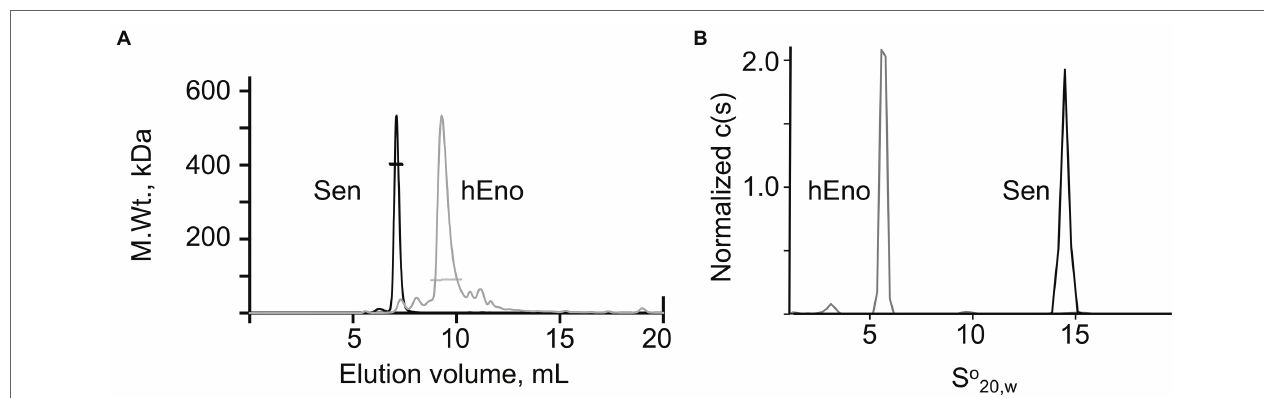
FIGURE 2 | Characterization of Sen and hEno. Quaternary structures of Sen and hEno. (A) Molecular weights of Sen and hEno by Size Exclusion Chromatography (SEC)-multi-angle light scattering (MALS). Each protein (100 μ l) was separately injected onto a Wyatt—030S5 column (7.6 mm × 300 mm, 5 μ M, 300 Å), equilibrated and eluted with PBS, pH 7.4, at a flow rate of 0.5 ml/min. The flow through was passed in-line through a three-angle light scatter apparatus coupled to a refractive index (RI) detector. RI fractograms for Sen (black line) and hEno (gray line) are plotted as M.Wt. vs. elution volume. The bars across each peak indicate the values of the molecular weights. The M.Wt. of the Sen is consistent with an octameric structure, while hEno is a dimeric structure. (B) Normalized sedimentation coefficient distributions of Sen and hEno at 20 ° C were obtained at 0.5, 1.0, and 2.0 mM for Sen and 6, 11, and 21 mM hEno (based on the M.Wts. of the Sen octamer and hEno dimer). The rotor speed was 30,000 rpm for Sen and 35,000 rpm for hEno, and the buffer was 50 mM Na-phosphate/0.1 M NaCl, pH 7.4. The data are plotted as the normalized continuous distributions, c(s), against the S o 20,w which were obtained by fitting the raw data to the Lamm equation using SEDFIT (available at https://spsrch.cit.nih.gov/). Scans were obtained every 3 min for 16